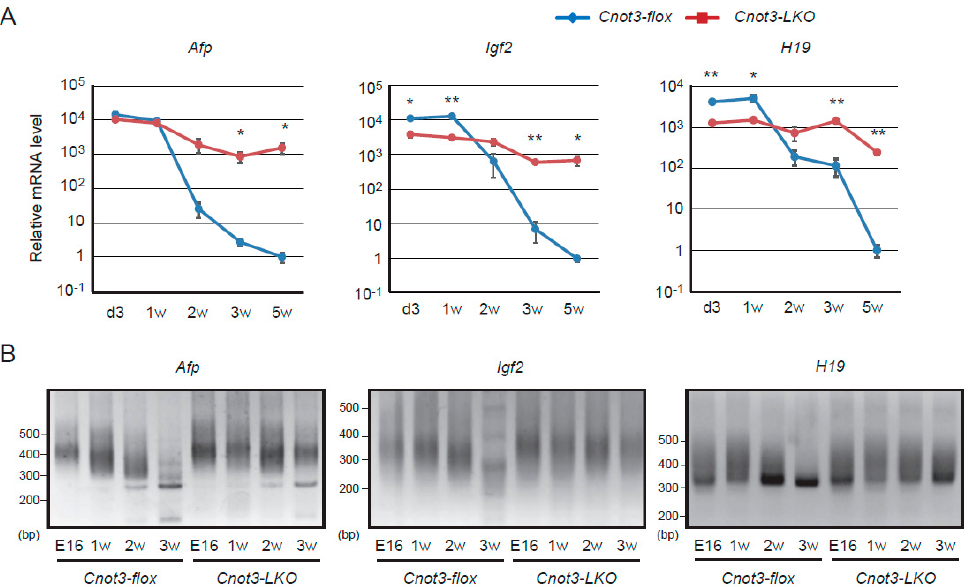
Figure 1. Afp , H19 and Igf2 transcripts maintain long poly(A) tails and fail to undergo postnatal decrease in the absence of CNOT3. ( A ) qPCR analysis of Afp , H19 , and Igf2 transcripts in livers from control and Cnot3-LKO mice at the indicated postnatal days. Gapdh mRNA levels were used for normalization. Levels in 5-week-old (5 w) control mice are set to 1 ( n = 3). Values in graphs represent means ± sem. * p < 0.05, ** p < 0.01. ( B ) Comparison of poly(A) tail lengths of liver transcripts from control and Cnot3-LKO mice at the indicated postnatal days. Total RNA was subjected to PCR-based analysis (see Methods).